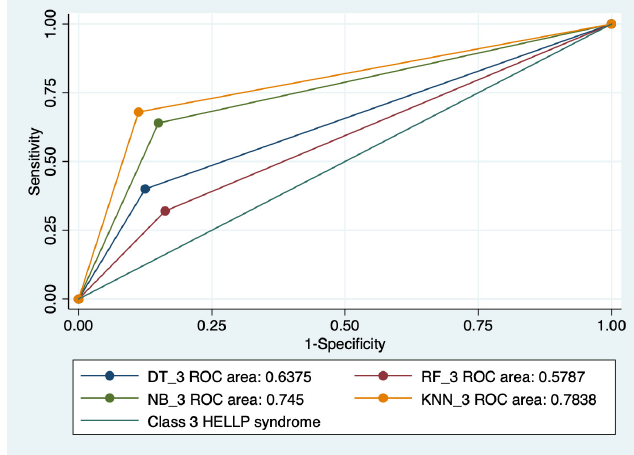
Figure 8. Multiple ROC curves comparison between different machine learning models for class 3 HELLP syndrome. Legend: ROC—Receiver operating characteristic; DT—decision trees; NB—naïve Bayes; KNN—k-nearest neighbors; RF—random forest. Table 6. The results from ROC analysis of machine learning-based models for the HELLP syndrome and its subtypes.